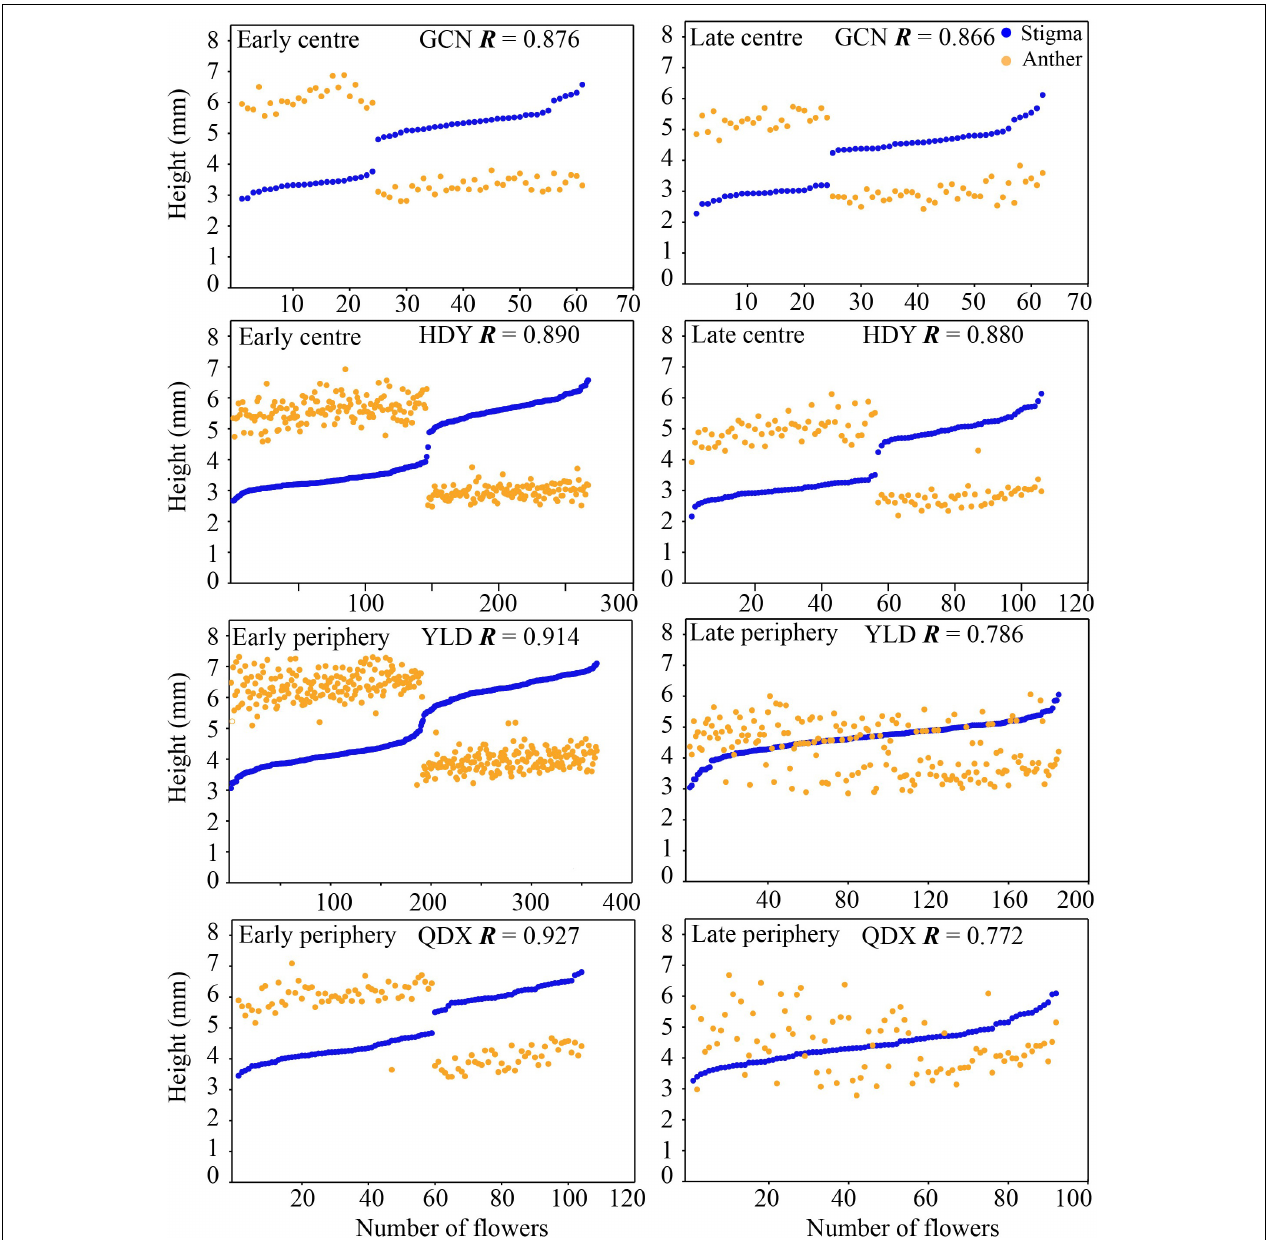
FIGURE 4 | Scatterplots of relative stigma height (SH) and anther height (AH) of each sampled P. wannanensis plant at different flowering phases. R represents the global reciprocity index of Sánchez et al.